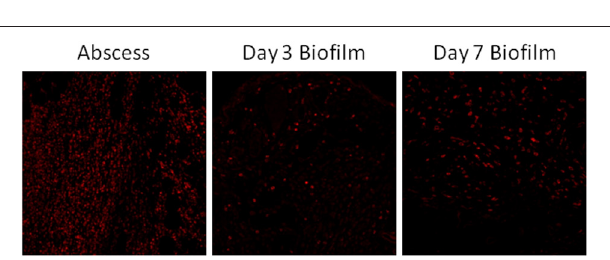
recognition. The macrophage is a major cellular infiltrate during device-associated biofilm infections; however, current evidence indicates that macrophage microbicidal properties are inhibited by the biofilm.